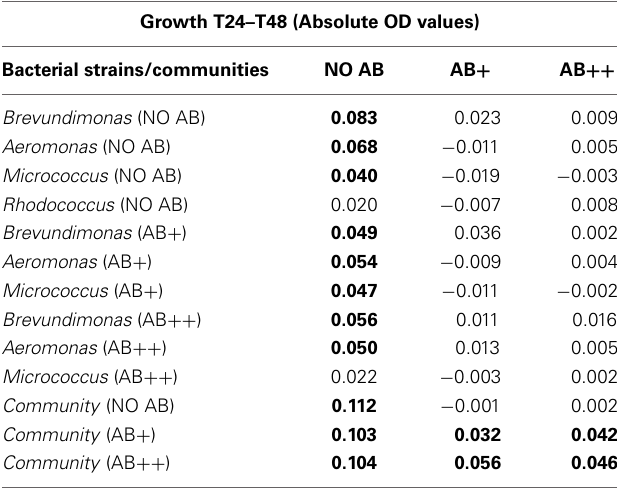
Table 2 | Growth of re-isolated strains and reassembled